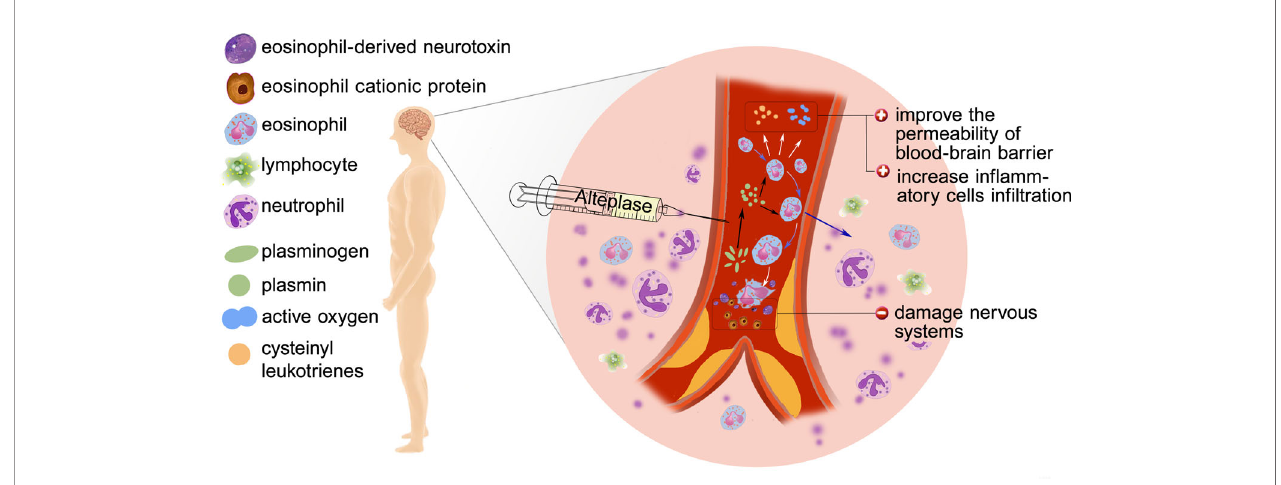
FIGURE 6 | Possible mechanisms of poor outcome: Eosinophil in fi ltration, release of in fl ammatory factors, degranulation and release of toxic